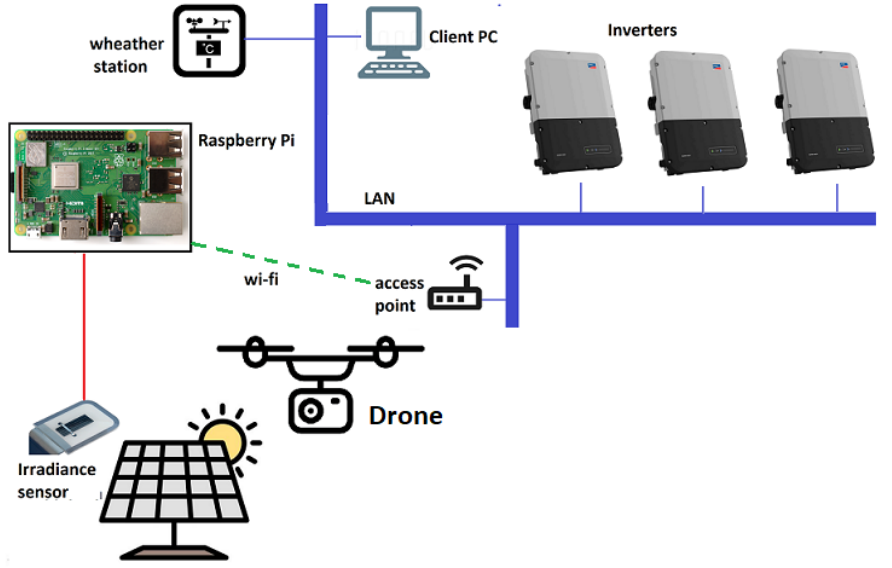
Figure 5. Schematic diagram of the instrumentation and communication links used to access the information sources of the experiment.